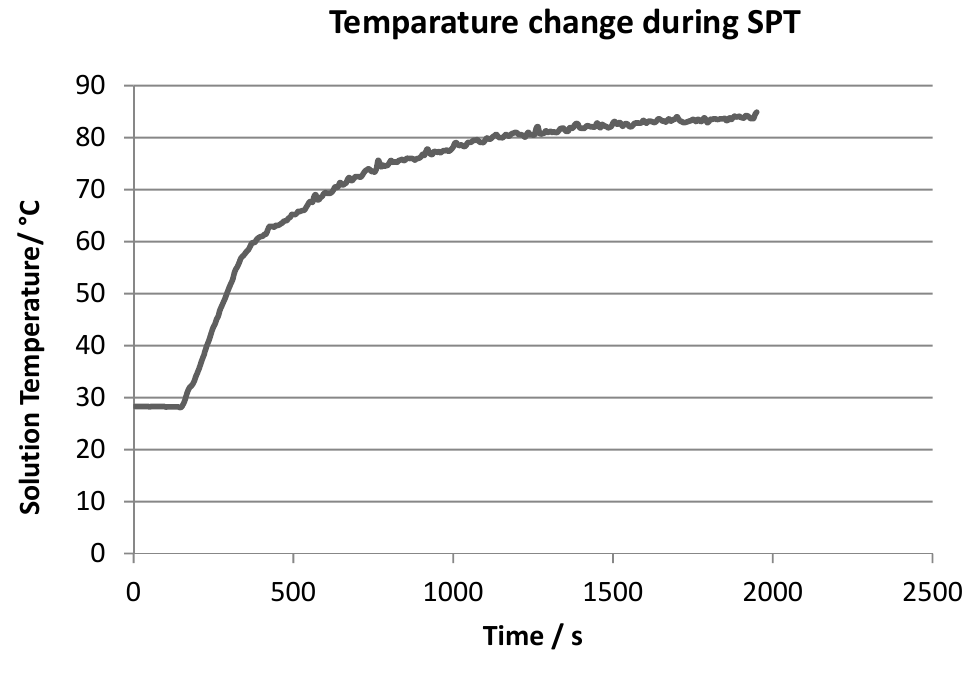
Figure 2. Variation of solution temperature in the vicinity of the sample with time, during solution plasma treatment (SPT). The temperature increased rapidly and exceeded 60 °C within 3 min after starting SPT, and then increased slowly and reached an almost constant value of 80 °C at 30 min.